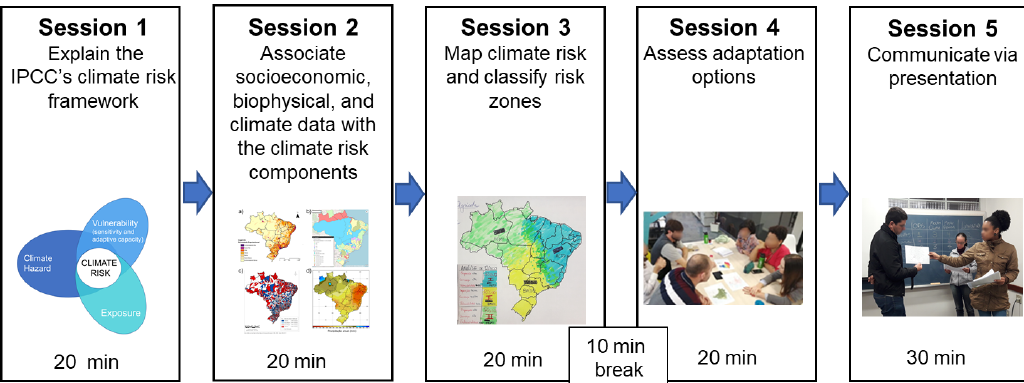
Figure 2. Scheme of the training sessions (adapted from IPCC, 2014; MMA, 2017; Planos de Recursos Hídricos, 2020; Brasil, 2017; Normais climatológicas do Brasil, 2020).